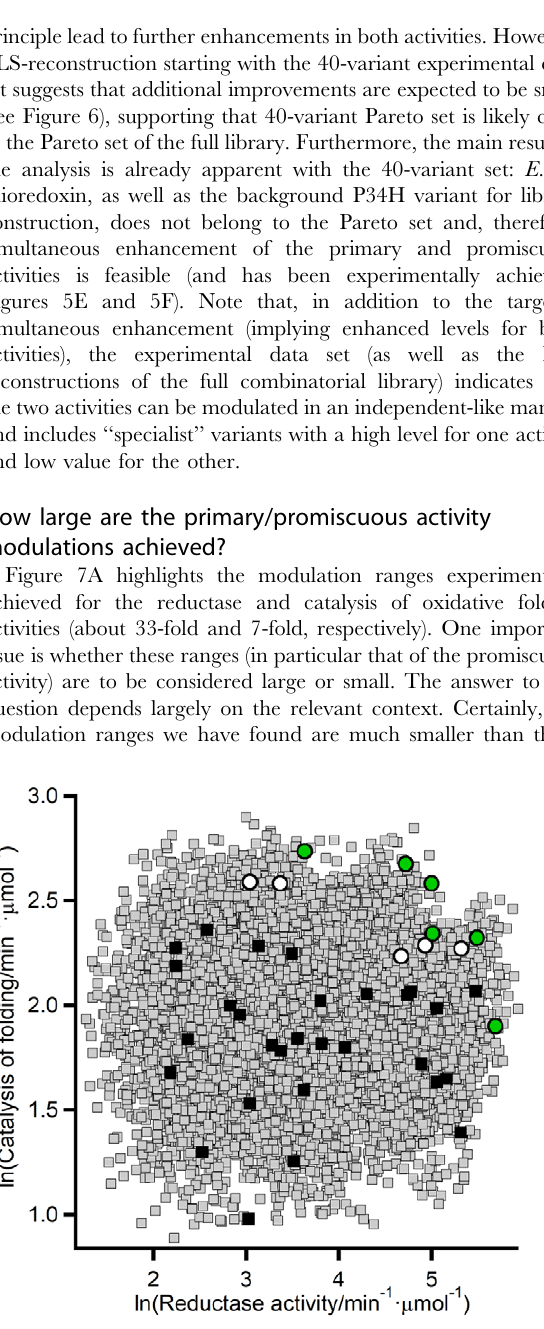
Figure 6. Full-library partial-least-squares reconstructions of the reductase/catalyis-of-oxidative-folding data based upon the expanded 40-variant set. The black squares represent the first- round 29-variant set and the circles represent the 11 variants added as a result of the experimental validation of the Pareto prediction shown in Figure 5C (green data points are used here for the Pareto set). Error bars have been omitted for clarity, but they are shown in Figures 5E and 5F. The reconstructed data (grey squares) are derived from 20 boot- strapping replicas of the 40-variant data. Note that the PLS reconstructions shown here are based on the expanded 40-variant set, while those of Figure 5B were based on the first-round 29-variant set. The full-library reconstructions shown here suggest only small enhancements over the 40-variant Pareto set would be obtained in additional screening rounds and, further, they support that the 40- variant Pareto set is already close to the full-library Pareto set.